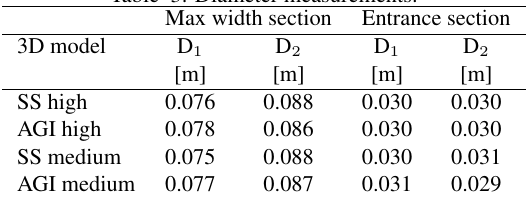
Table 3: Diameter measurements. Max width section Entrance